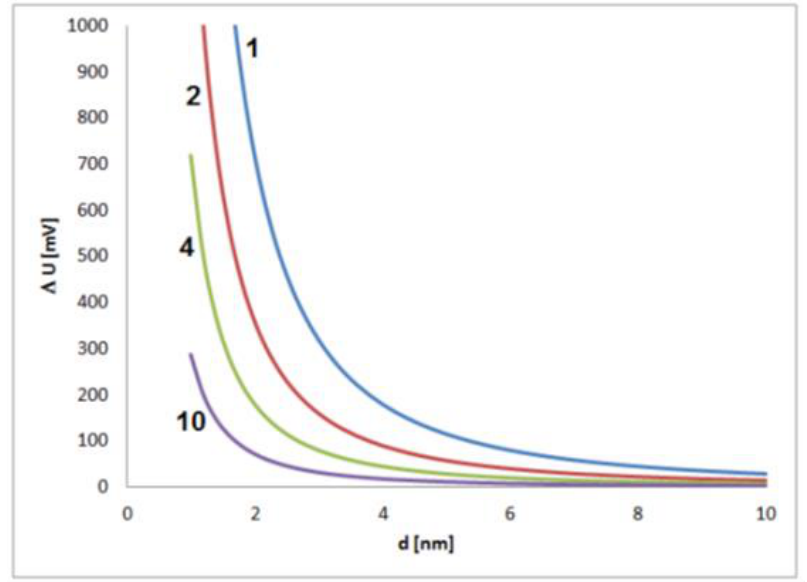
Figure 2. Estimated contribution of a single elementary charge on the potential of a single metal nanoparticle in dependence on the particle size for values of dielectric constant (electrical permittivity) of 1, 2, 4 and 10 and an assumed thickness of the electrochemical double layer of 0.5 nm. In a later phase, when the particle consists already of about thousands or more at-